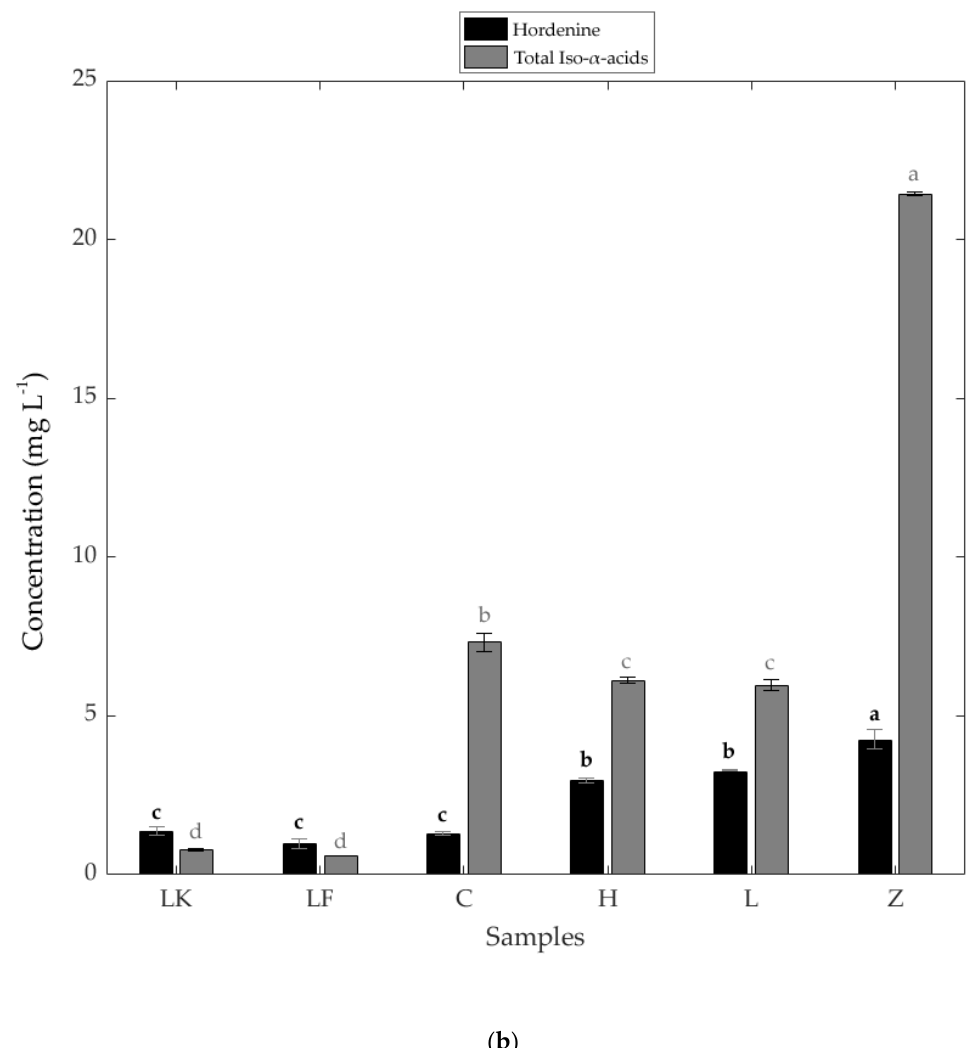
Figure 1. Chemical characterization of commercial beers, including ( a ) total sugars (mg mL −1 ), bitterness (IBU), ( b ) hordenine (mg L −1 ), total Iso-α-acid concentration (mg L −1 ). Different letters above bars denote significant differences between beer samples, for the same chemical parameter, according to the least significant difference test (LSD; p < 0.05). * Total sugars not detected in beer C. All values are the mean ± SE (error bars) of independent determinations. n = 3, hordenine, and bitterness; n = 2, total sugars, and total-α-acids. Abbreviations of samples may be found in Table 1.